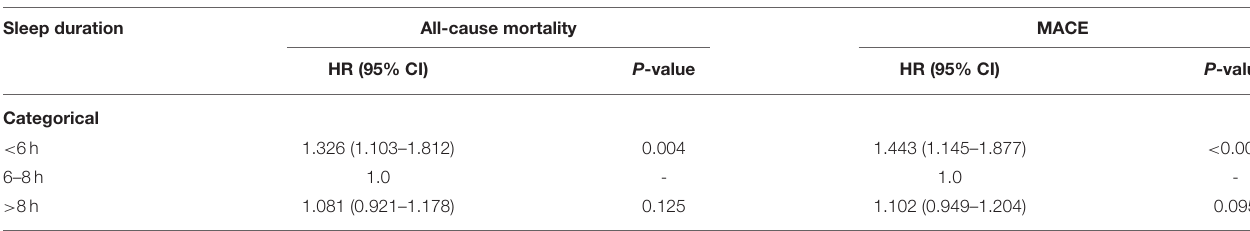
TABLE 6 | Relationship of sleep duration with all-cause mortality and MACE during follow up